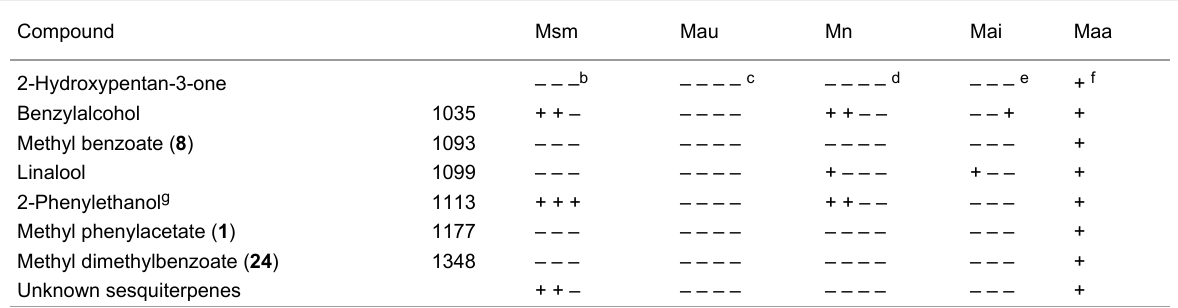
Table 8: Volatiles released by diverse nontuberculous mycobacteria grown in a Sauton liquid medium. a